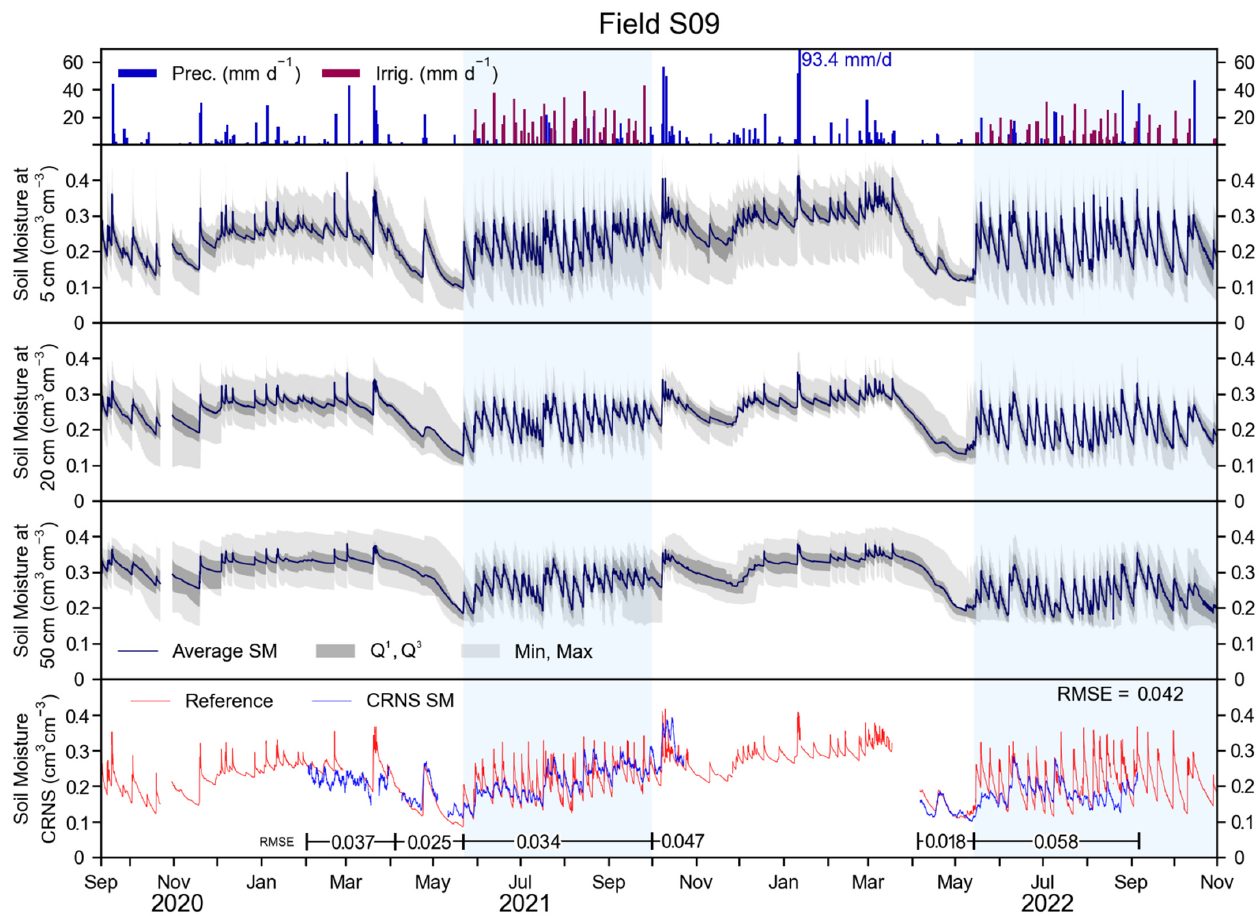
Figure 3. In the upper panel: precipitation for field S10, and irrigation for field S09 in mm d − 1 . In the three central panels: SM recorded from the SoilNet network of field S09 at 5, 20, and 50 cm depths. Dark grey areas indicate the first and third quartile, whereas the light grey area indicates maximum and minimum values for the SM of these panels. In the bottom panel: reference SM from weighting the SoilNet network and CRNS-derived SM for field S09. Regressions of these measurements are provided in Appendix C.